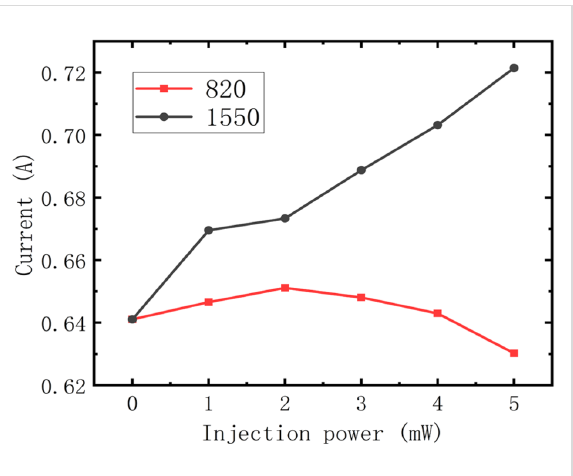
Figure 6: Current vs optical injection power at wavelengths of 1550 nm (black circles) and 820 nm (red squares).